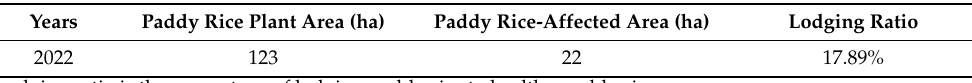
Table 2. Summary statistics of the disaster from measurement data from local